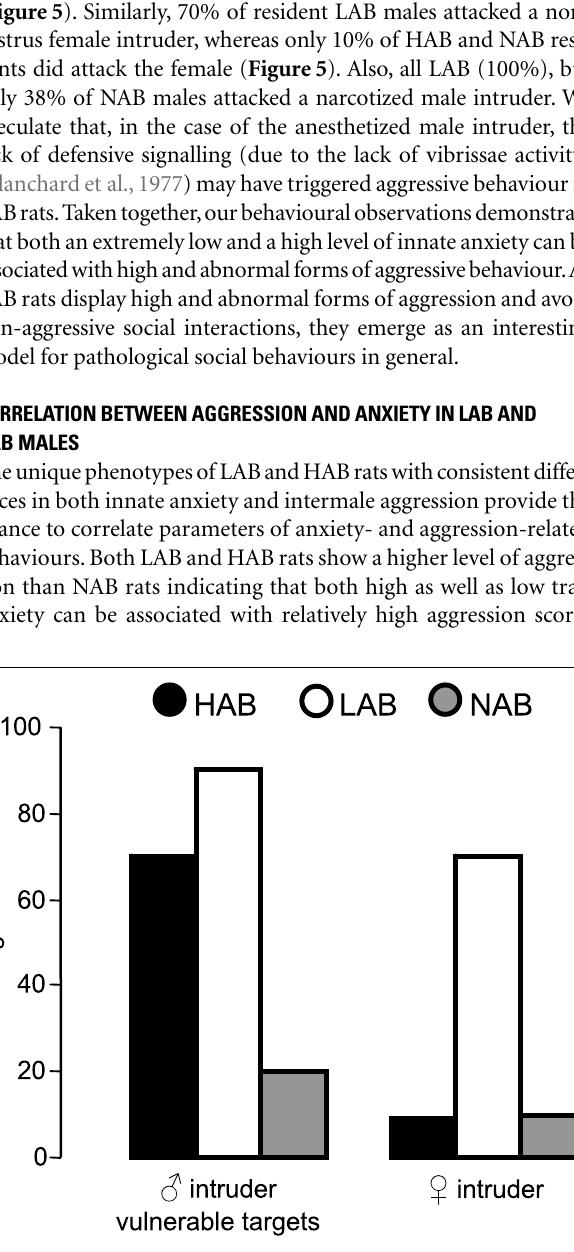
FIGURE 5 | Line-specifi c differences in abnormal aggression as indicated by the percentage of HAB, LAB and NAB male rats attacking vulnerable body parts of a male intruder (left) or a female intruder (right) during the RI test in their home